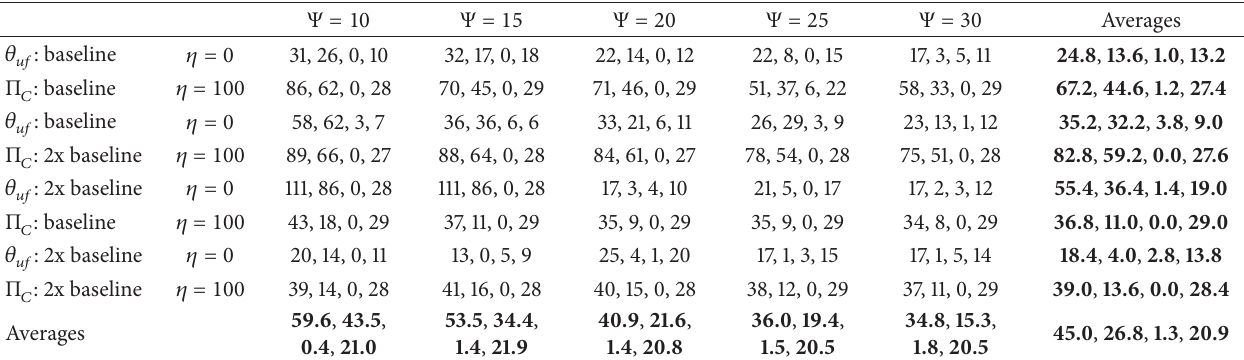
Table 3: Further computational results, unconstrained maximum transport distance.